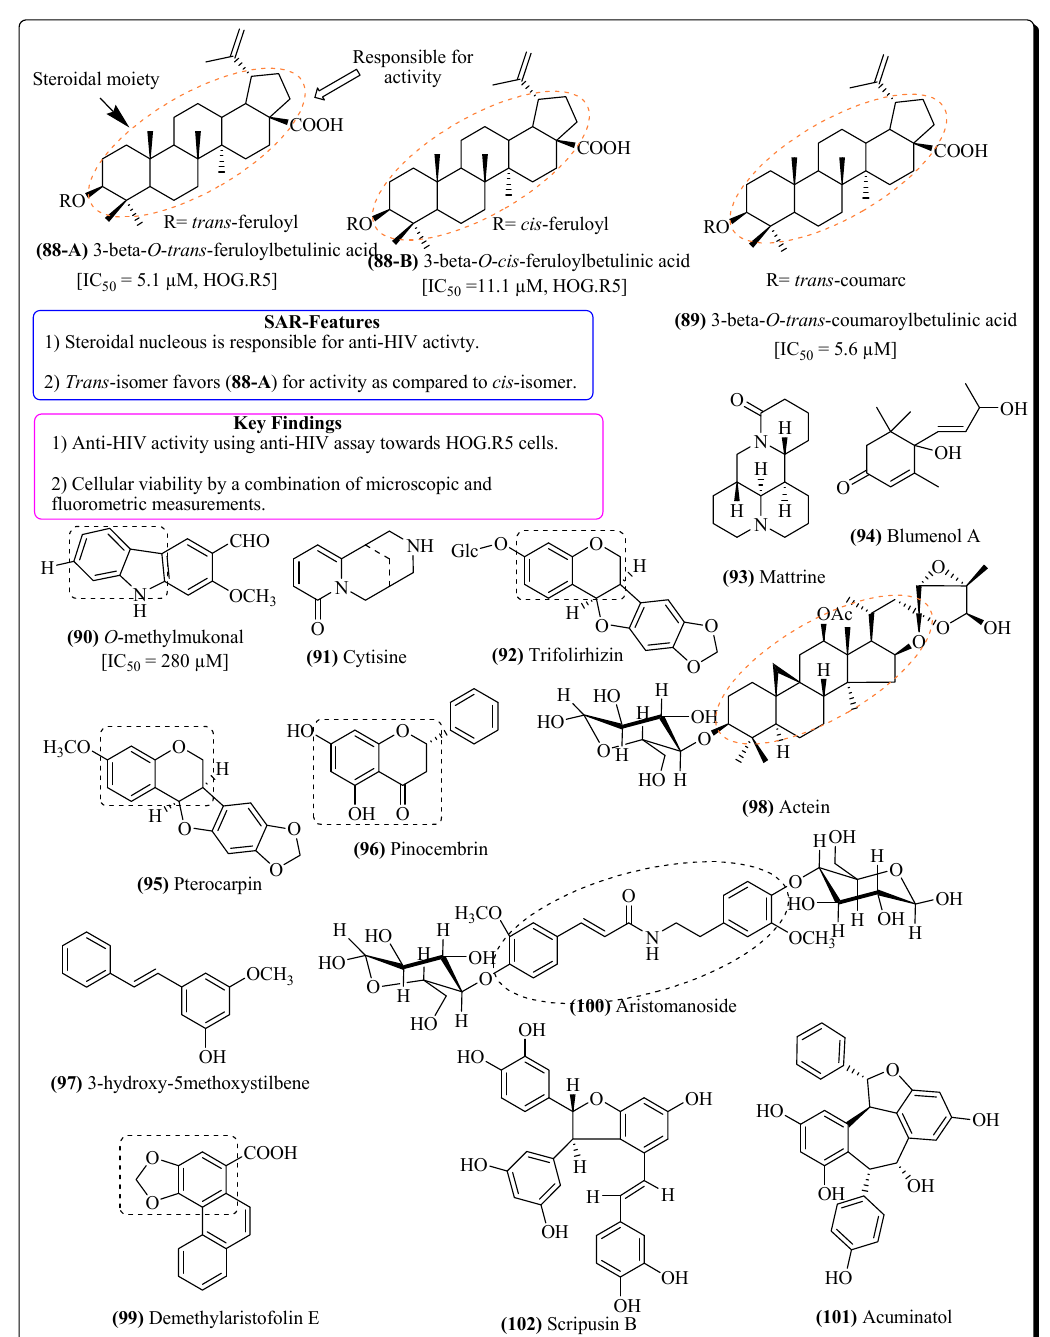
Figure 18. Other plant-based compounds with anti-HIV